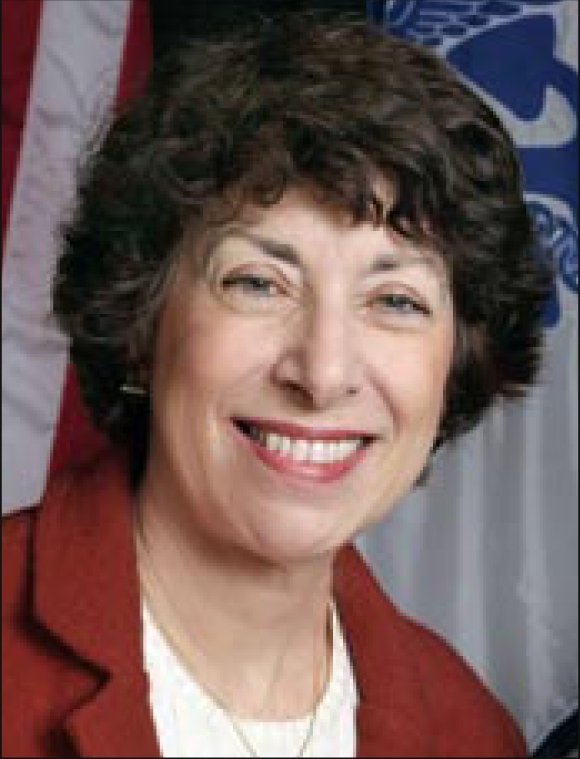
Linda S. Birnbaum